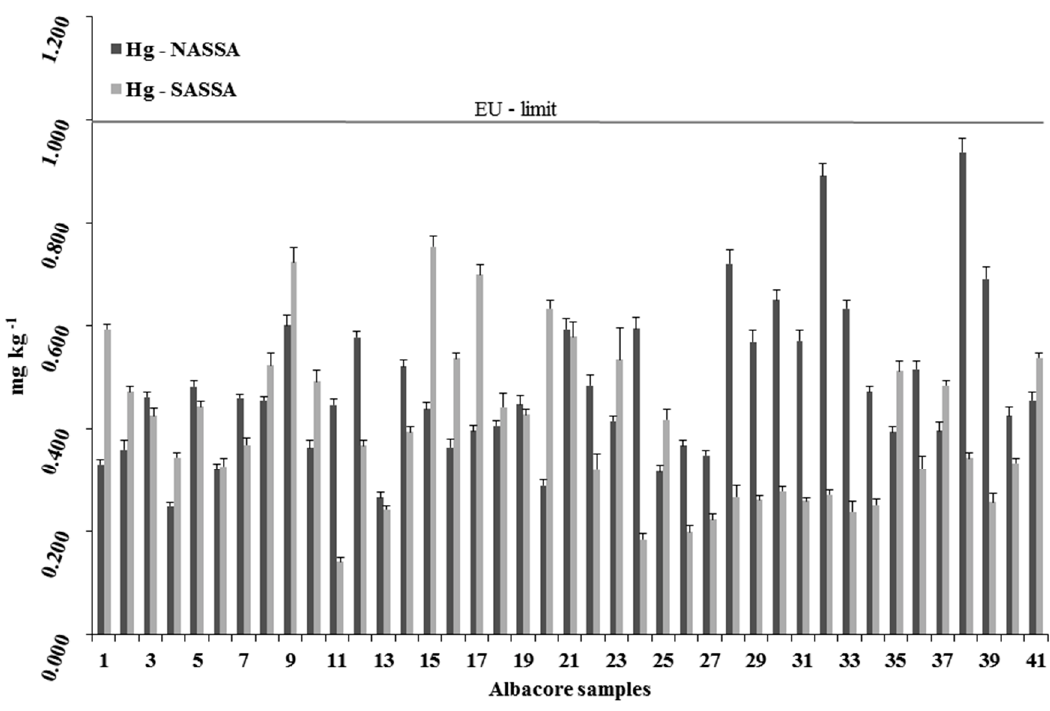
Figure 5. Mercury concentrations in each individual T. alalunga , caught from NASSA and SASSA areas.